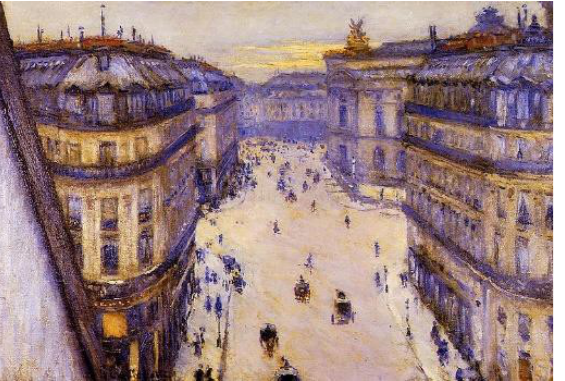
Fig. 11 Avenue de l'Opera, Morning Sunshine - by 1897 - 964 ×